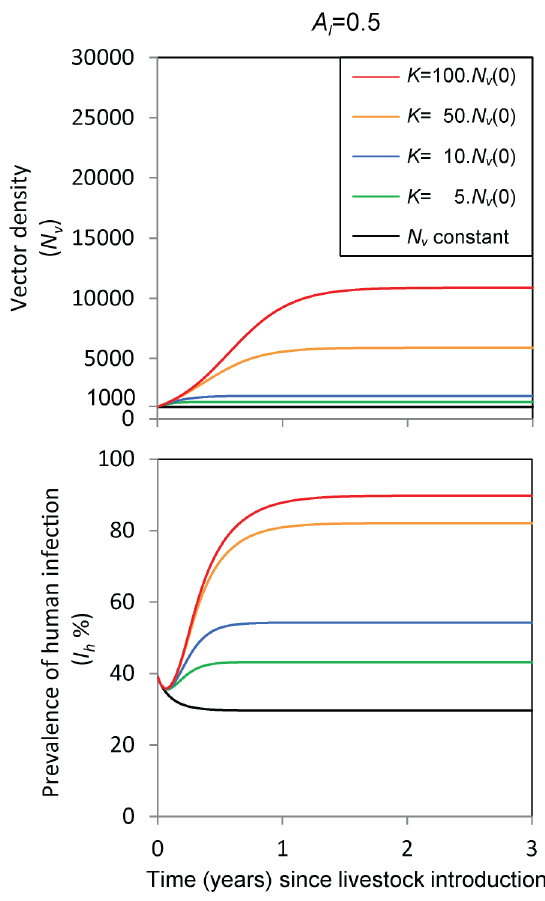
Figure 2. Temporal effect of introducing livestock in a setting with endemic malaria. Effect of introducing livestock in a setting where only humans were present, when: N v remains constant (black line), and when N v increases until reaching a maximum, which depends on the carrying capacity, K (increasing from K =5,000 (green) to 100,000 (red)). N v (0)=1000, N h =100 and A l =0.5: the availability of livestock to vectors is the same as that of humans; h Nl =0.25 (1 head of livestock per 4 persons). To achieve the same initial equilibrium N v (and I h ) for various K values, the vector recruitment rate in the absence of density-dependence constraints was set to vary accordingly: r 0 ~ m h K = ( K { N v (0)) . Other parameters are as in Table 1.